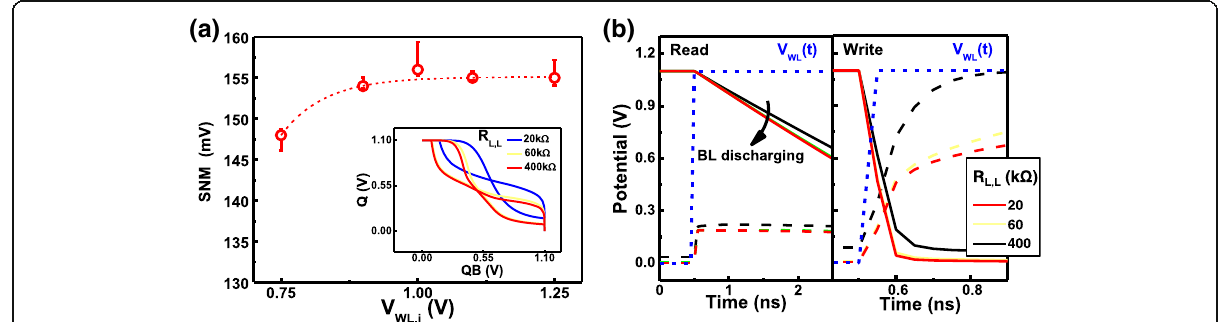
Fig. 8 a The read static noise margin (SNM) of the proposed SRAM cells with different WL voltage during initialization. Reasonable SNM can be maintained within a fairly large range of R L,L of 20~400 k Ω . b Dynamic read and write characteristics of a cell under balance load condition reveal good response time within nano-seconds. Higher R L,L slightly reduces the pull-up speed during write